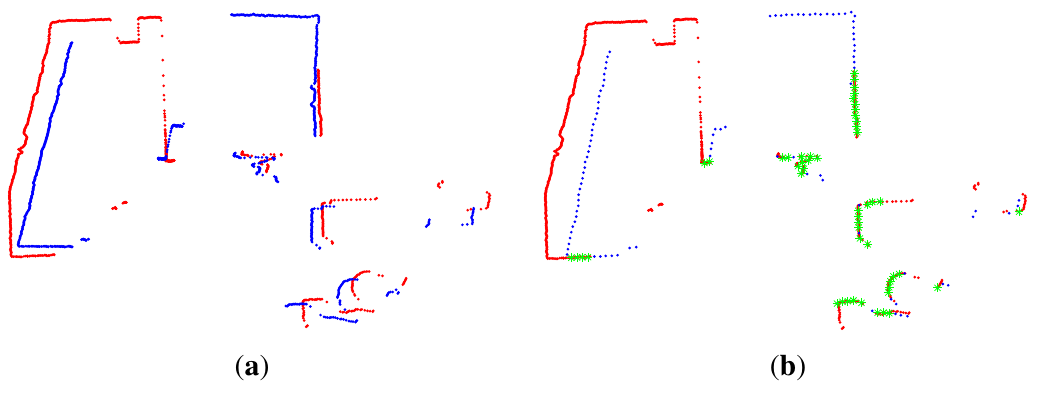
Figure 5. An example of performing the FICP algorithm. ( a ) The individual scans, depicted in red and blue, aligned using the initial estimate of the transformation. ( b ) The scan pairs after the FICP algorithm has been performed. The portion of geometry declared as the inlier points are denoted in